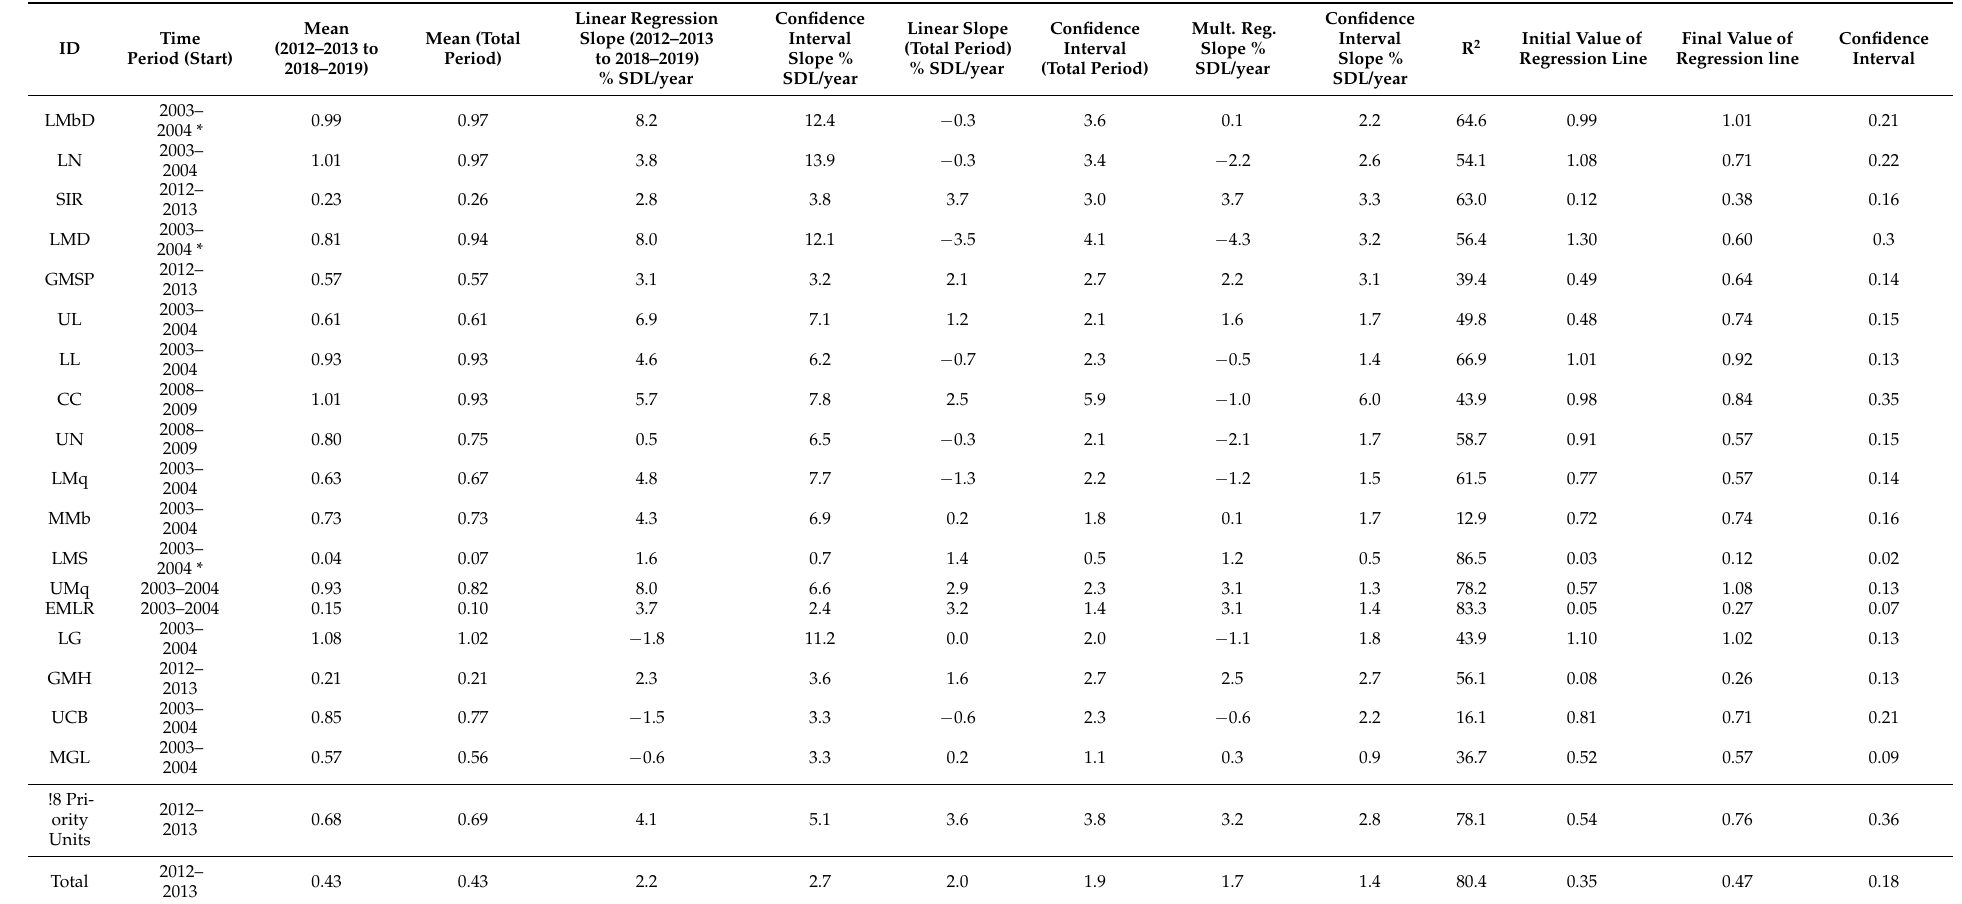
Table 1. Showing the starting period for data availability, mean for the period of 2012–2013 to 2018–2019 and for the whole period of data availability, slope with standard error for the period of 2012–2013 to 2018–2019 and for the whole period of data availability; the multiple regression statistics (slope with standard error and R 2 ) and the predictions at the initial values and final values of data availability and the standard error in the predictor. In column 2, * denotes that extraction for deep aquifer has been derived from total extraction for groundwater unit by using an assumed value for extraction from shallow unit before